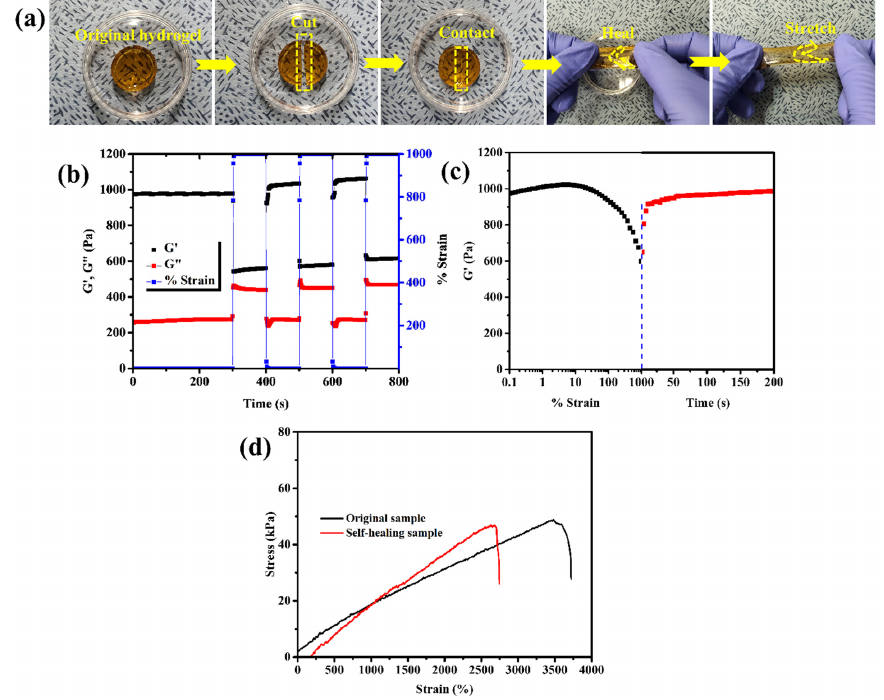
Figure 4. ( a ) Digital photographs of self-healing of 0.4DA-FCMCS hydrogel and its stretchability, ( b ) dynamic rheology of 0.4DA-FCMCS hydrogel under two different strains (1% and 1000%), ( c ) rheology of storage modulus for 0.4DA-FCMCS hydrogel; black figure shows strain amplitude from 0.1% to 1000% and red figure shows the release of strain amplitude from 1000% to 1% with respect to time, and ( d ) tensile stress–strain curve of original hydrogel and self-healed hydrogel.